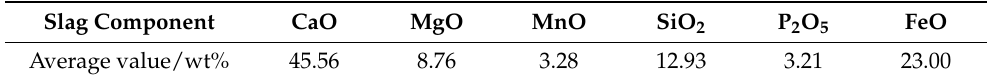
Table 1. Final slag composition of 120 t converter. Slag